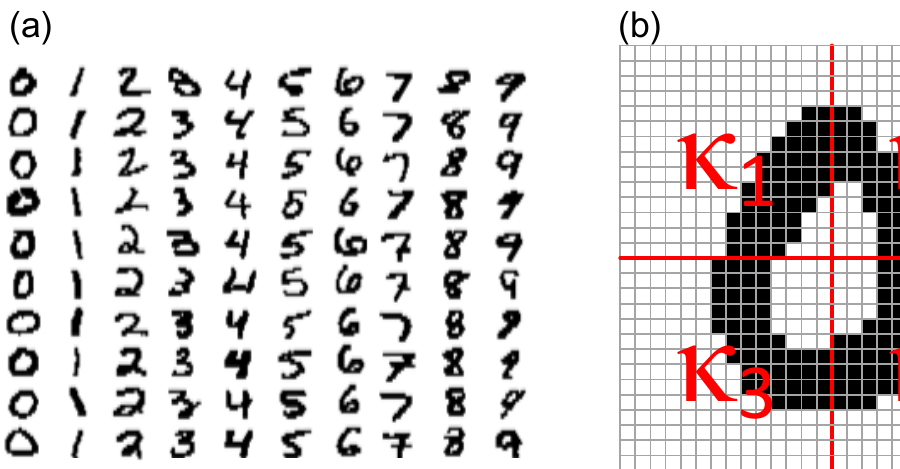
Figure 5. A small sample of the MNIST handwritten digits ( a ) and an image depicting the definition of quadrants for the 28 × 28-pixel image ( b ).